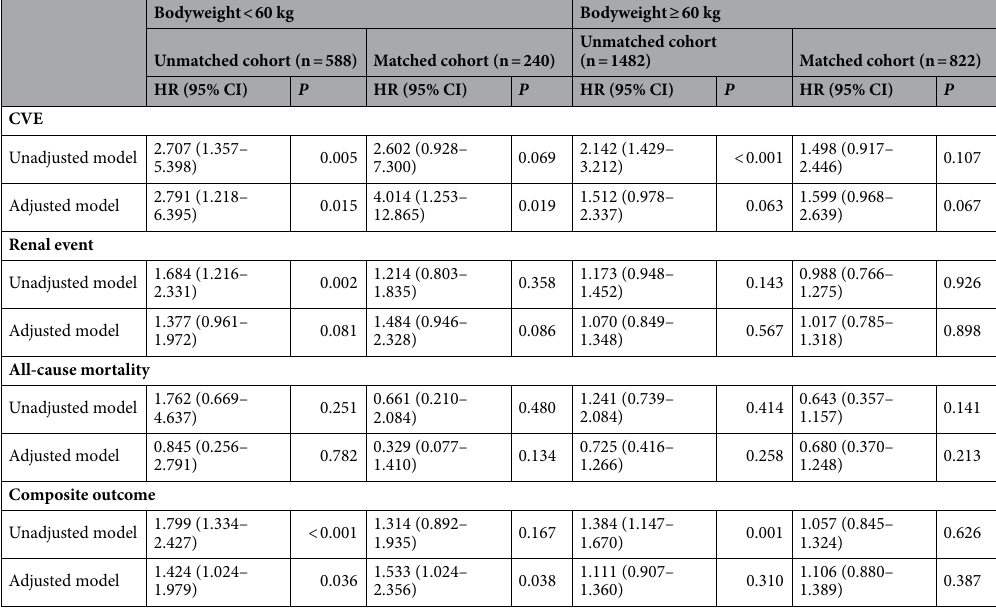
Table 4. Multivariate Cox proportional analyses for clinical outcomes according to dichotomized bodyweight (< 60 kg vs. ≥ 60 kg). Adjusted for age, male gender, BMI, smoking, baseline eGFR, previous CVD, diabetes, hypertension, proteinuria, hemoglobin, albumin and total cholesterol levels, and use of medications (RAAS blockers, CCB, beta-blockers, statin, warfarin, and other antiplatelet